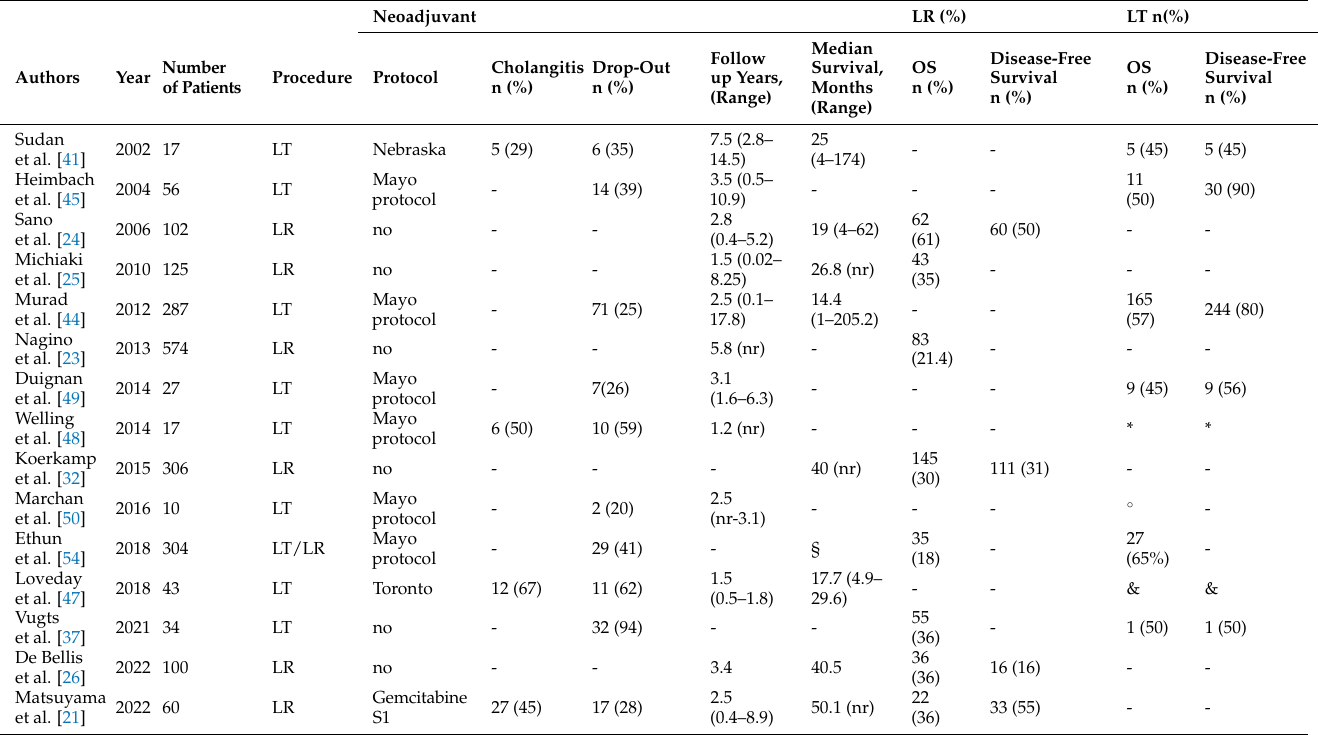
Table 2. Liver transplantation or resection for